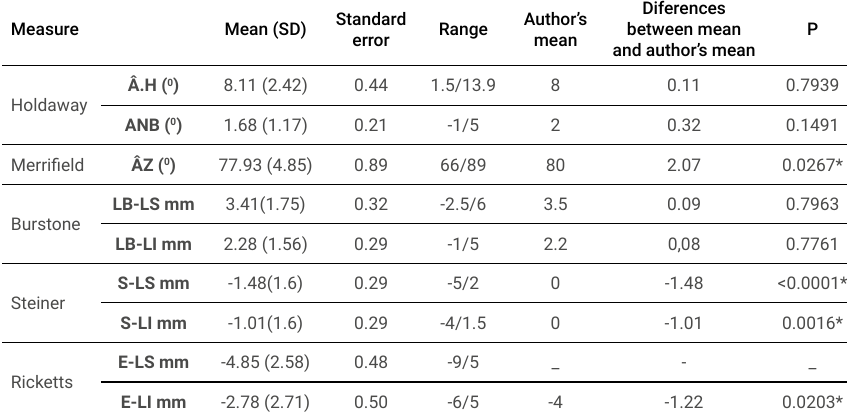
Table 1. Statistical results for measurement values obtained for white Brazilian adults and the values recommended by authors for an analysis of facial profile soft tissues Measure Mean